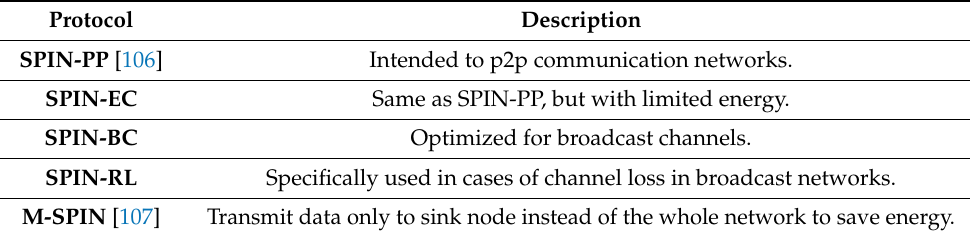
Table 9. Family routing